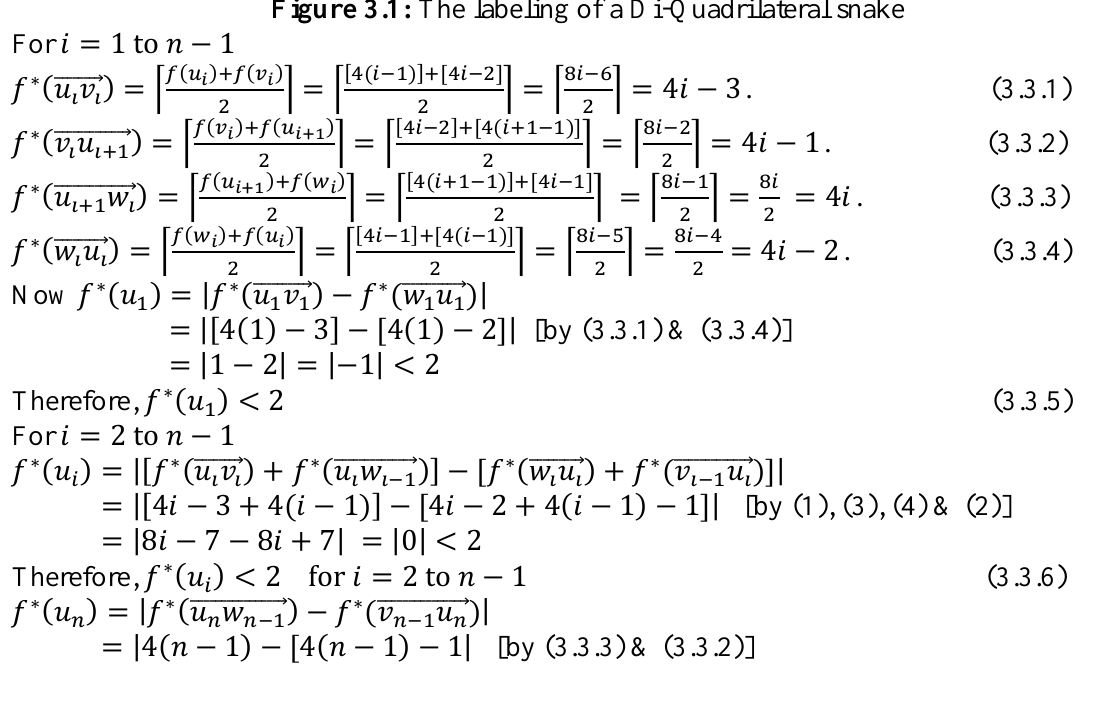
Figure 3.1: The labeling of a Di-Quadrilateral